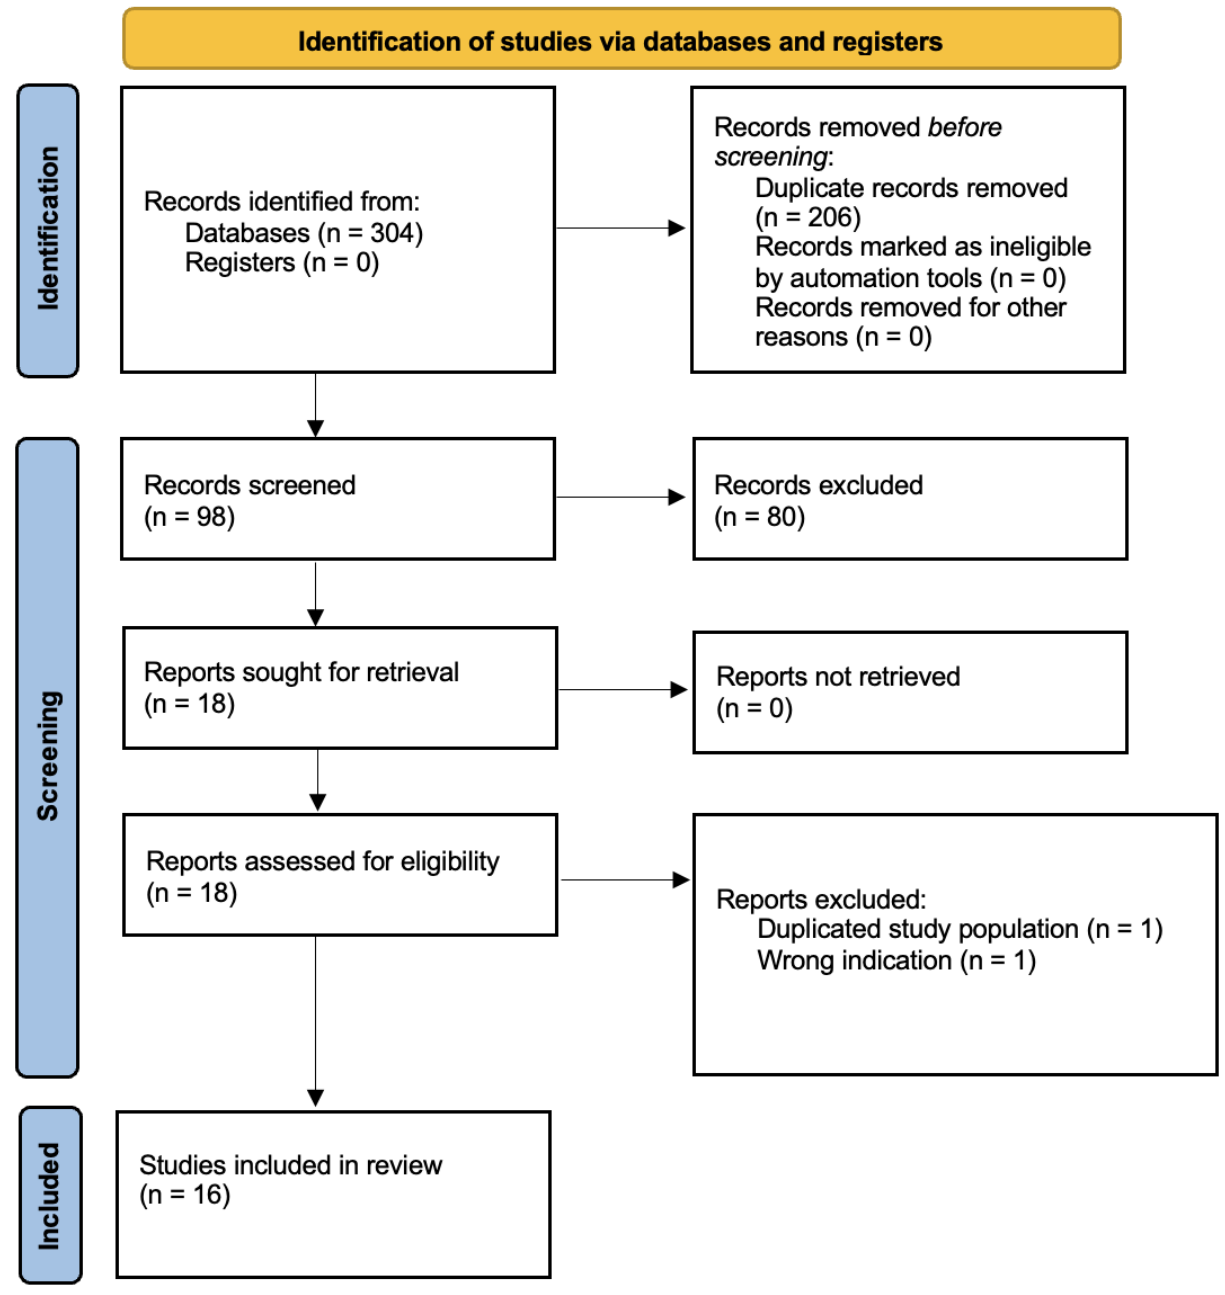
Figure 1. PRISMA [21] flow diagram for the systematic review detailing the databases searched, the number of abstracts screened, and the full texts retrieved.